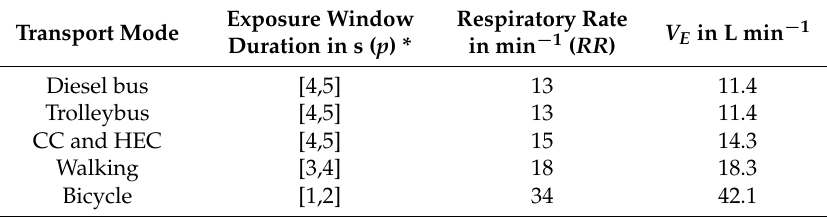
Table 2. Respiratory parameters used in the current study to estimate inhalation of PM 2.5 by mode of